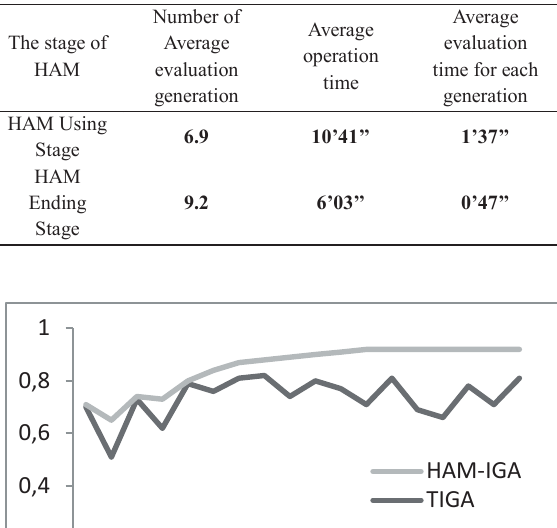
Table 4. The influence of the application of HAM on the system